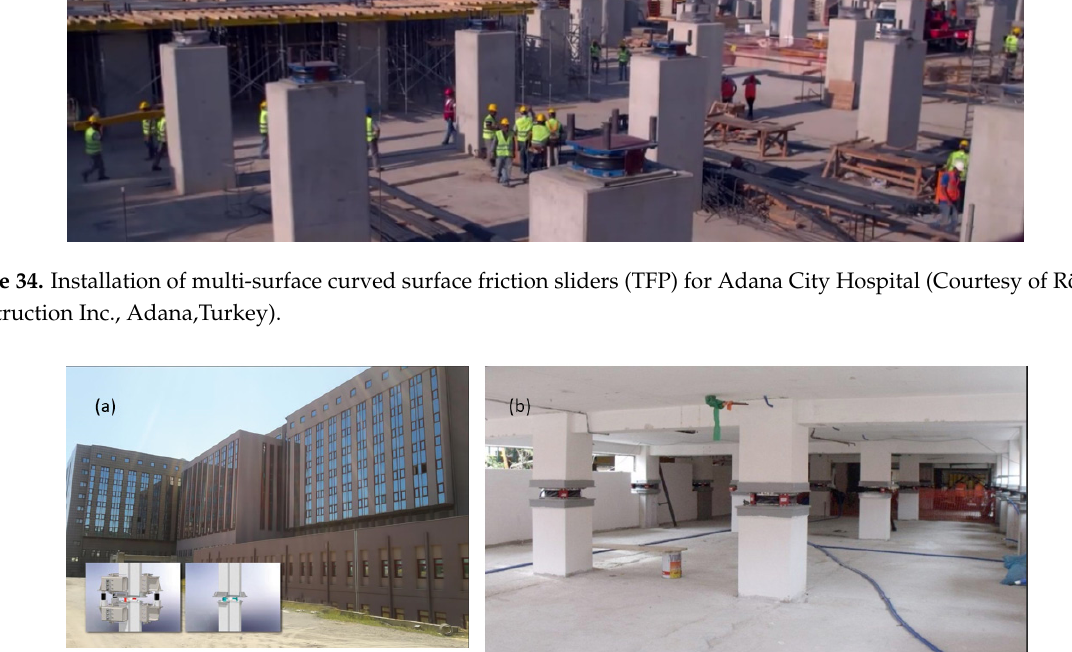
Figure 34. Installation of multi-surface curved surface friction sliders (TFP) for Adana City Hospi- tal (Courtesy of Rönesans Construction Inc.) .